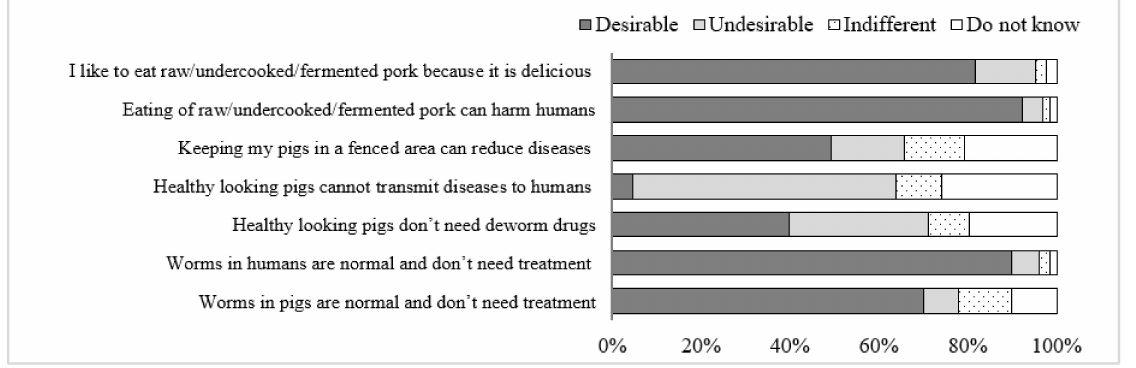
Figure 2. Attitudes of participants on FBPDs risk, prevention and treatment in Da Bac district, Hoa Binh province,